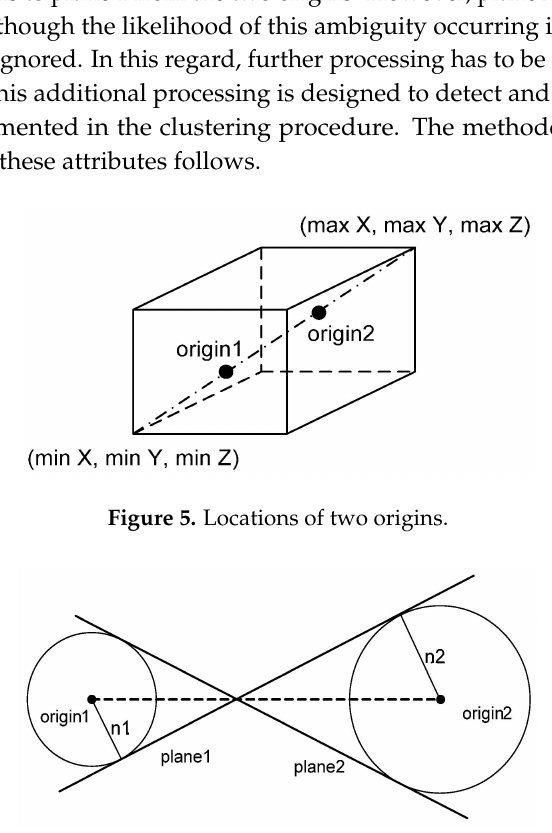
Figure 6. Example of ambiguity from two origins (side